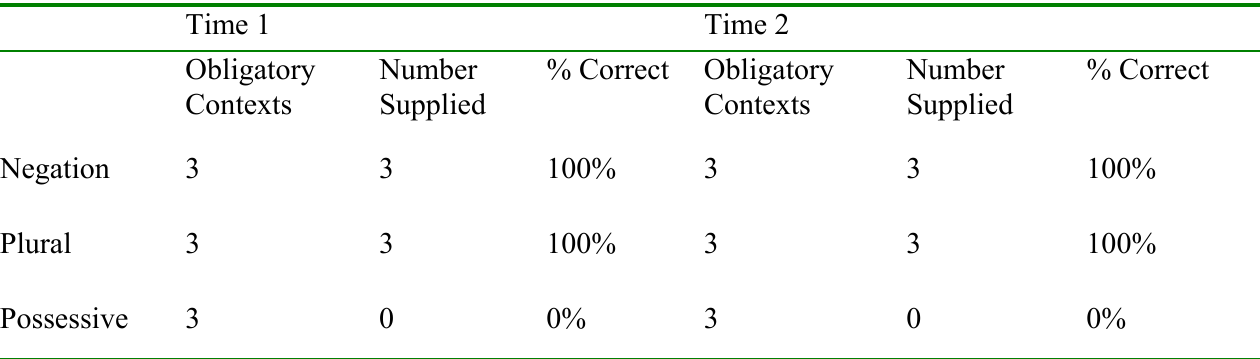
Results of Story-and-Picture Cued Sentence Production